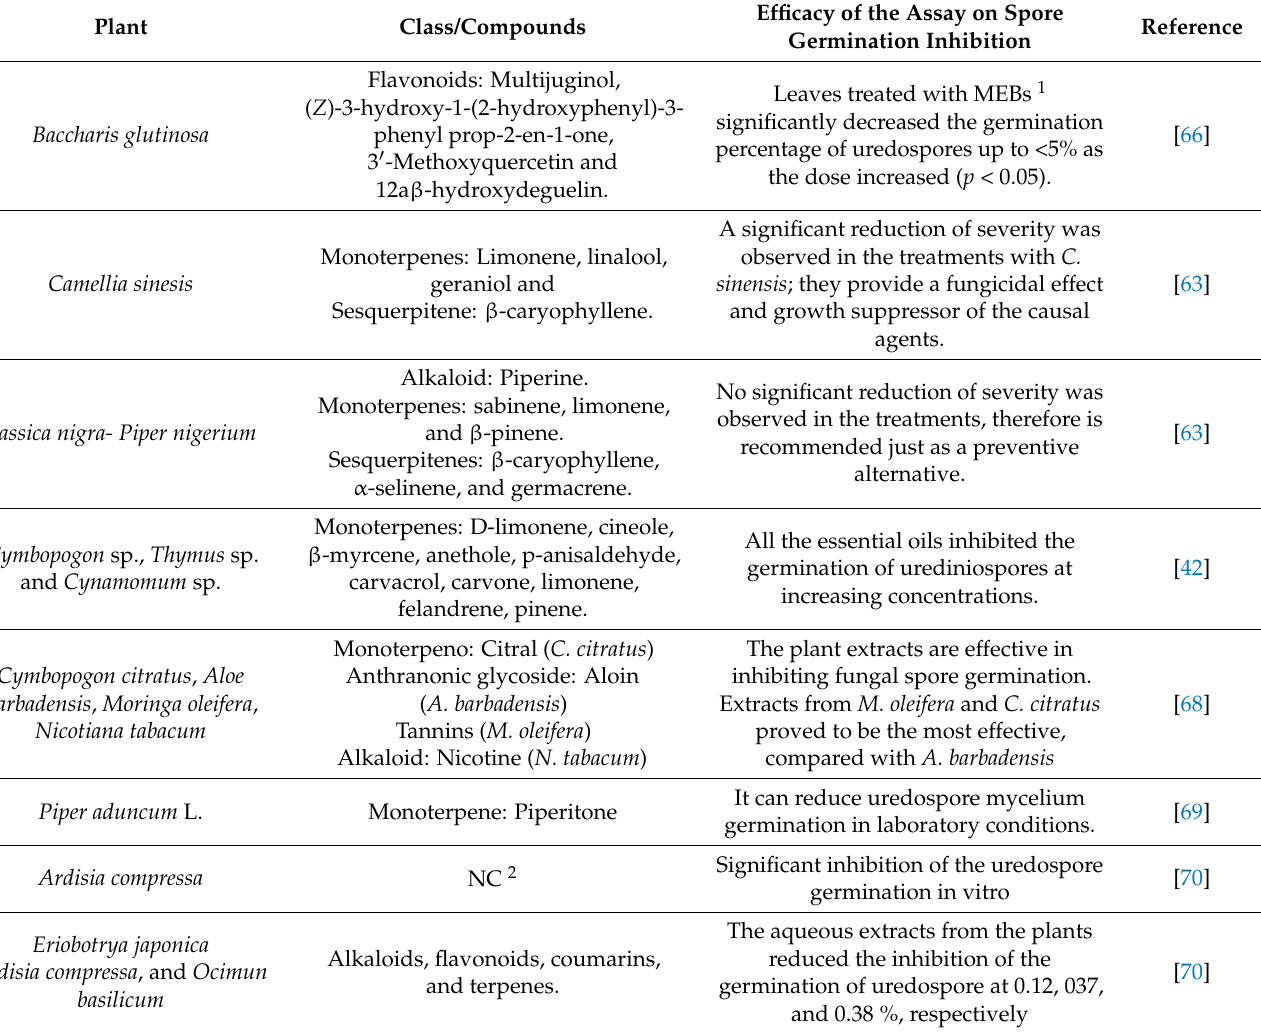
Table 2. Experimental assays based on phytochemical compounds from plants with activity against